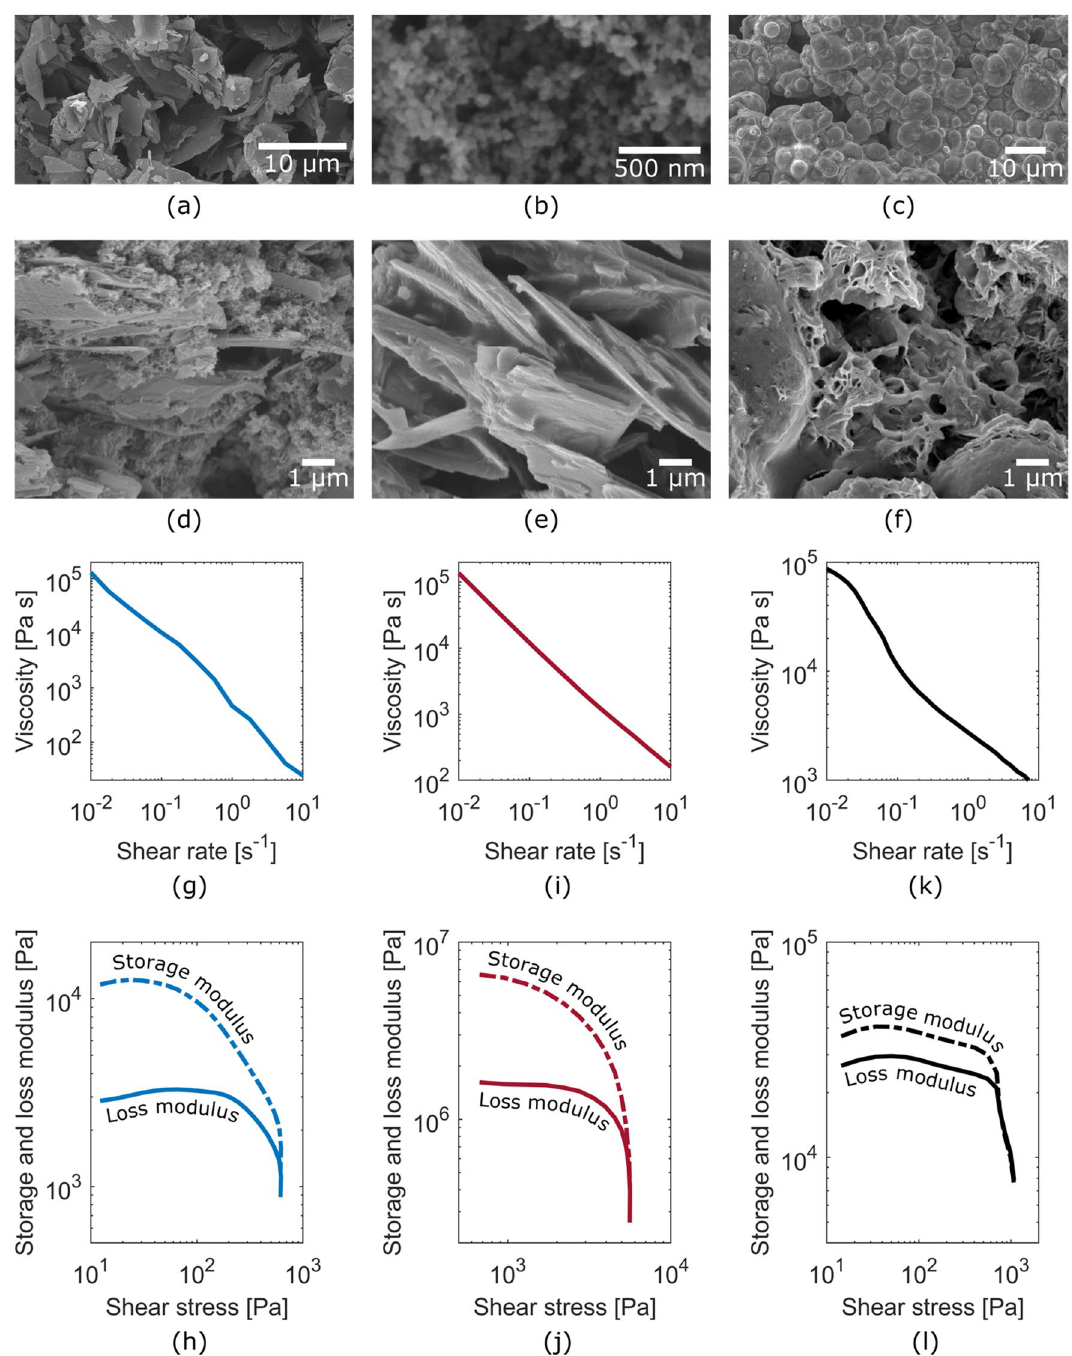
Figure 2. SEM micrographs of the ( a ) graphite flakes, ( b ) carbon black and ( c ) zinc particles comprised in the battery. ( d ) SEM micrograph of the current collector showing the densely packed graphite flakes, carbon black and shellac composite structure. ( e ) SEM micrograph of the cathode showing the loosely packed graphite flakes and shellac composite structure. ( f ) SEM micrograph of the anode on a partially discharged battery showing the porous shellac matrix that remains after zinc is consumed. ( g ) Graph of the viscosity as a function of shear rate showing the shear-thinning behavior of the current collector ink. ( h ) Graph of the storage and loss modulus as a function of shear stress showing the 600 Pa yield stress of the current collector ink. ( i ) Graph of the viscosity as a function of shear rate showing the shear-thinning behavior of the cathode ink. ( j ) Graph of the storage and loss modulus as a function of shear stress showing the 5600 Pa yield stress of the cathode ink. ( k ) Graph of the viscosity as a function of shear rate showing the shear-thinning behavior of the anode ink. ( l ) Graph of the storage and loss modulus as a function of shear stress showing the 750 Pa yield stress of the anode